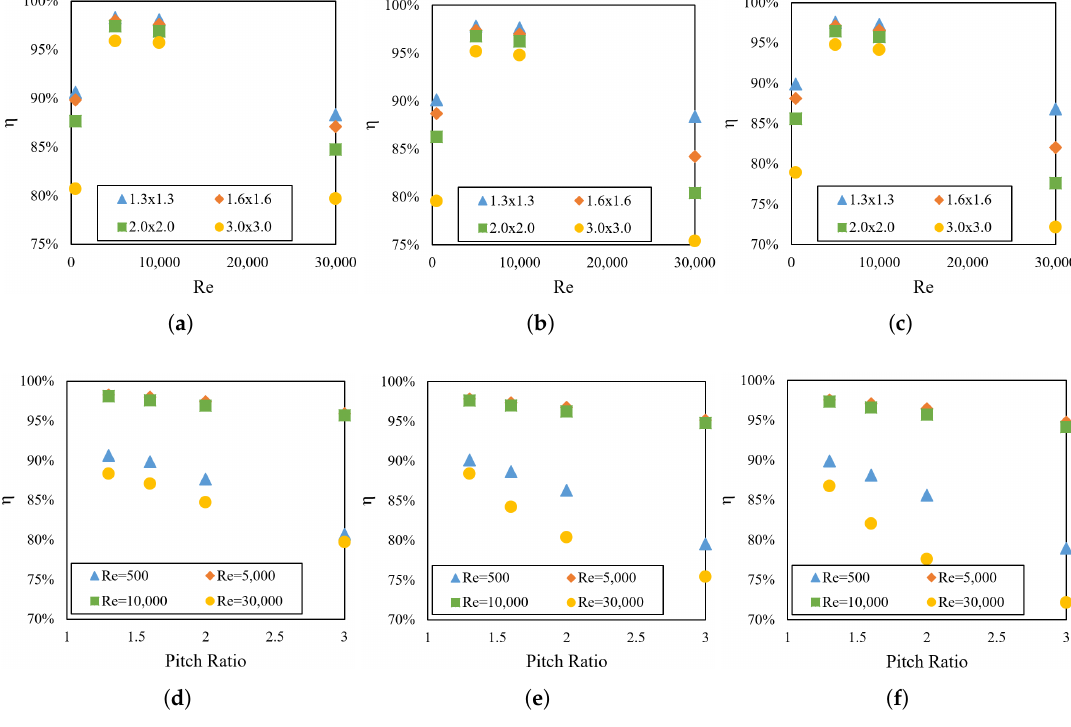
Figure 8. Energy efficiency for ( a ) 8 tubes, ( b ) 4 tubes and ( c ) 3 tubes varying the Reynolds number for all four pitch ratios. ( d – f ) show the same 8-, 4- and 3-tube cases while varying the pitch ratio for four different Reynolds numbers.